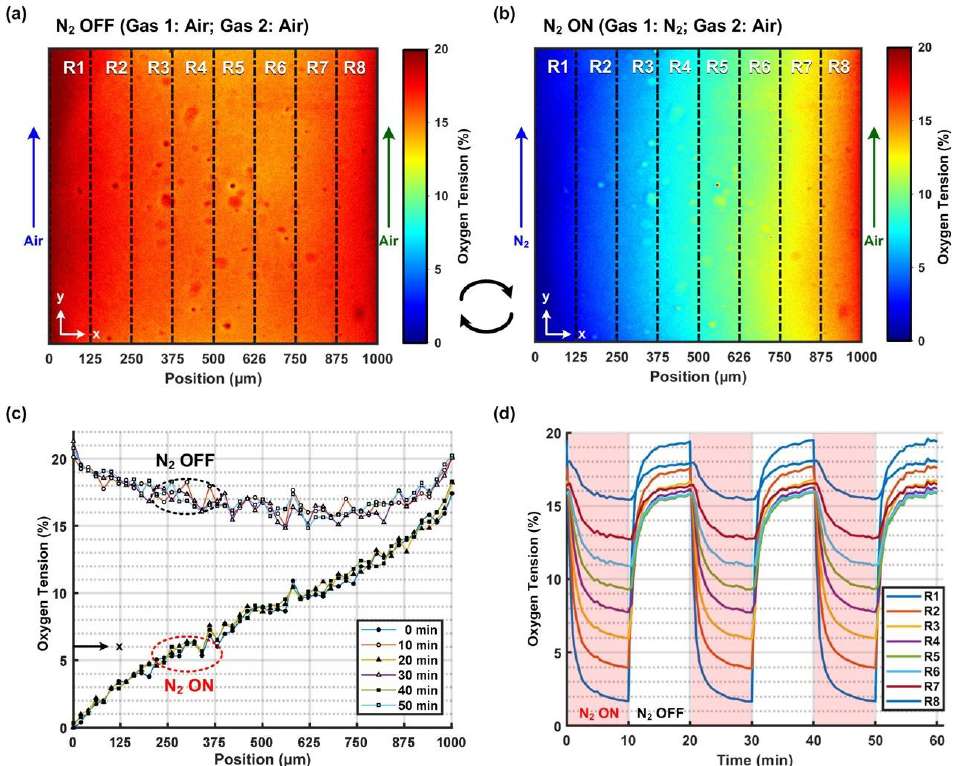
Figure 2. ( a , b ) are the characterized oxygen profiles without (N 2 OFF) and with (N 2 ON) oxygen gradients, respectively. ( c ) Line profiles show that consistent oxygen gradients (solid symbol lines) can be established when nitrogen gas is on (N 2 ON), and relative uniform normoxia conditions (hollow symbol lines) can be recovered by air purging (N 2 OFF). ( d ) The temporal variation in average oxygen tension values from the leftmost (R1) to the rightmost region (R8). Cyclic oxygen tension profiles in different regions show that the oxygen tensions oscillate in the period of 20 min (10 min on/10 min